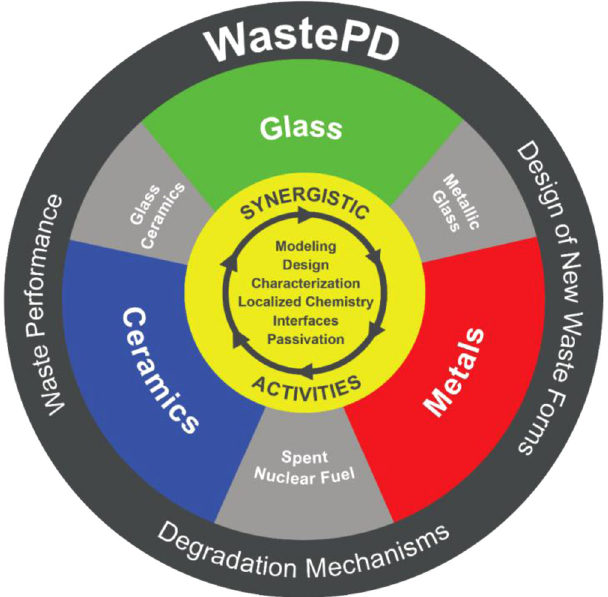
Fig. 1 Schematic representation of the organization of